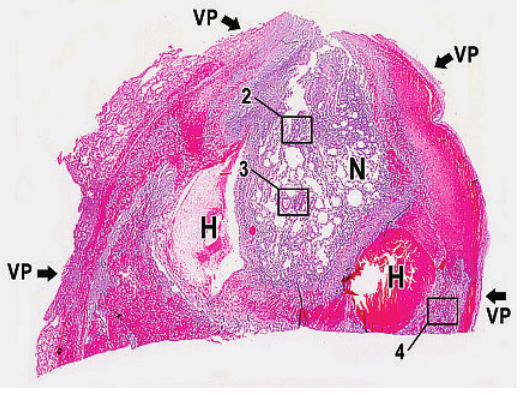
Figure 1 Macroscopic view of the tip of the resected lingula (no magnification) showing in its centre a triangular pulmonary lobule limited by two areas of haematoma (H) caused by the bullet.The visceral pleura (VP) is thickened due to acute fibrinous pleuritis. Areas in boxes are magnified in the next three figures (haematoxylin-eosin). N = zone of normal lung.